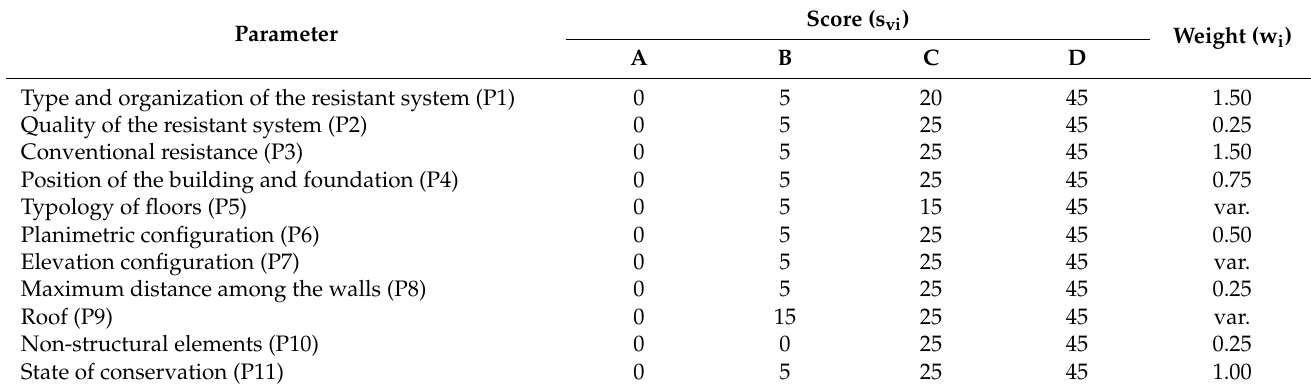
Table 1. Vulnerability parameters and their